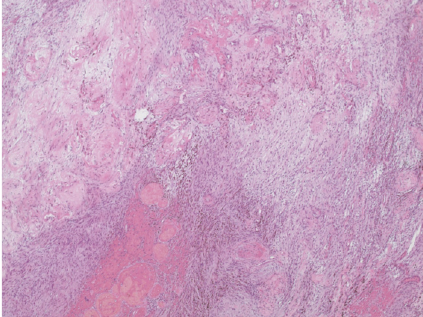
Figure 4: Histologic section showing prominent, hyalinized blood vessels with admixed hemosiderin (“ancient changes”) (H&E stain, 100x original magnification).